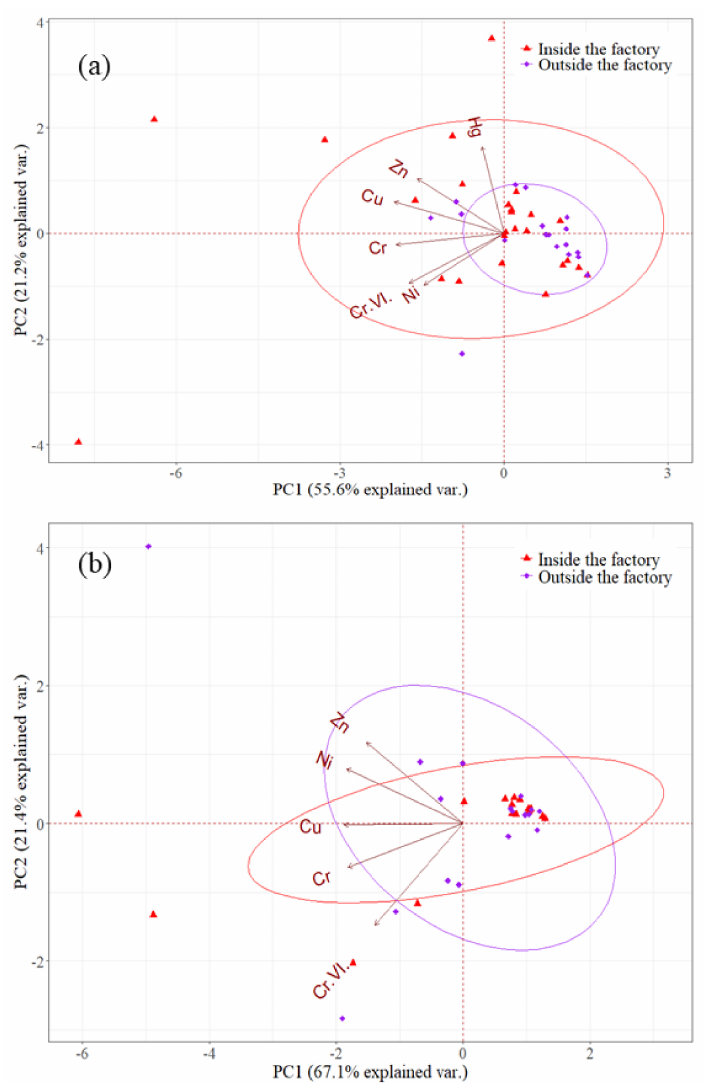
Figure 5. Contribution of each heavy metal to the primary component loading obtained by the principal component analysis from factories. The triangle points denote the samples collected in the factory site. The circle points denote the samples collected surrounding the factory site. The ellipses individually represent the regions in the factory site and surrounding area grouped by a default 68% confidence interval. Principal component score plot of sampling sites from ( a ) Factory A, ( b ) Factory